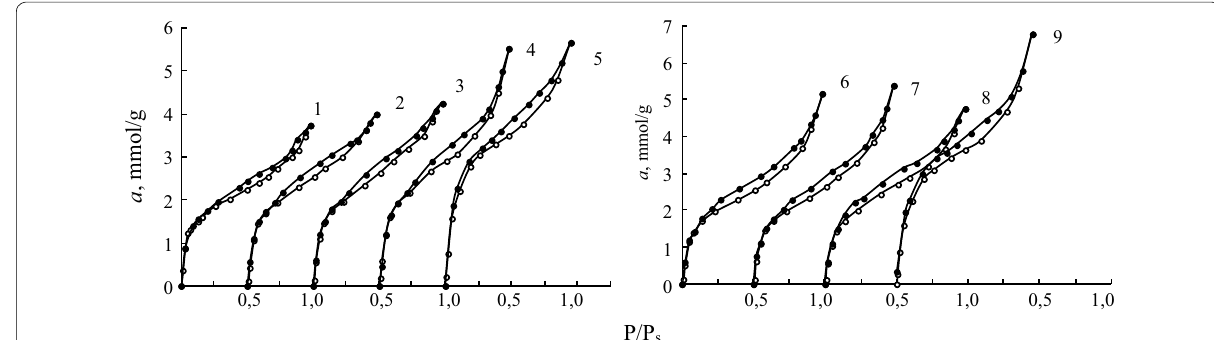
Fig. 4 Water vapor adsorption ( ○ ) and desorption ( ● ) isotherms for natural ( 1 ) and acid-modified 0.25H-CLI ( 2 ), 0.5H-CLI ( 3 ), 1H-CLI ( 4 ), and 3H-CLI ( 5 ) clinoptilolite samples as well as: Pd(II)–Cu(II)/0.25H-CLI ( 6 ), Pd(II)–Cu(II)/0.5H-CLI ( 7 ), Pd(II)–Cu(II)/1H-CLI ( 8 ), and Pd(II)–Cu(II)/3H-CLI ( 9 ) catalysts at t 21 °C. Curves 2–5 and 7–9 are shifted one from another by 0.5 P/P s =